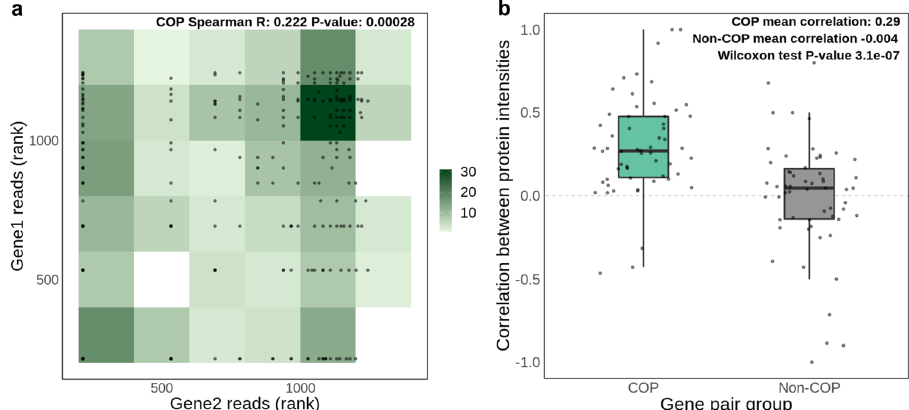
Fig. 3 GRO-seq and proteomics correlation in scCOPs. a GRO-seq read correlation for LCL scCOP genes for which data was available ( N = 264). Reads mapping to the TSS positions of each gene were considered. Gene pairs with missing data in at least one of the genes were excluded. The number of reads across all genes in COPs and non-COPs was ranked prior to plotting. Two genes sharing the same number of reads share the same rank; b correlation of protein intensities for each of 58 individual-experiments with iPSC proteomics data. The two-tailed Wilcoxon test refers to the comparison of correlation values between iPSC scCOPs and non-COPs for all 58 individual-experiments. The length of the box corresponds to the interquartile range (IQR) with the centre line corresponding to the median, the upper and lower whiskers represent the largest or lowest value no further than 1.5× IQR from the third and fi rst quartile,